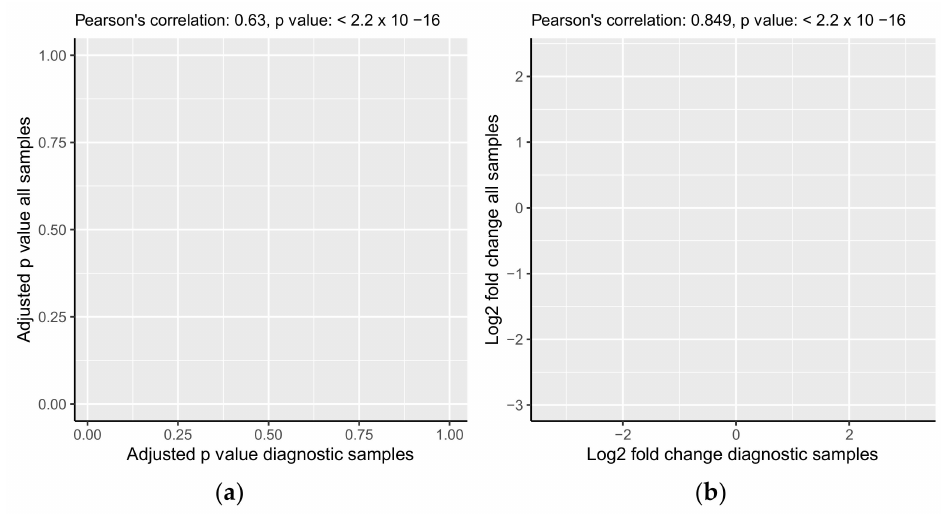
Figure 6. Comparison of the results of the DE analysis run on diagnostic samples and all samples combined, showing the relationship between the two models’ adjusted p values ( a ) and predicted log2 fold changes ( b ).